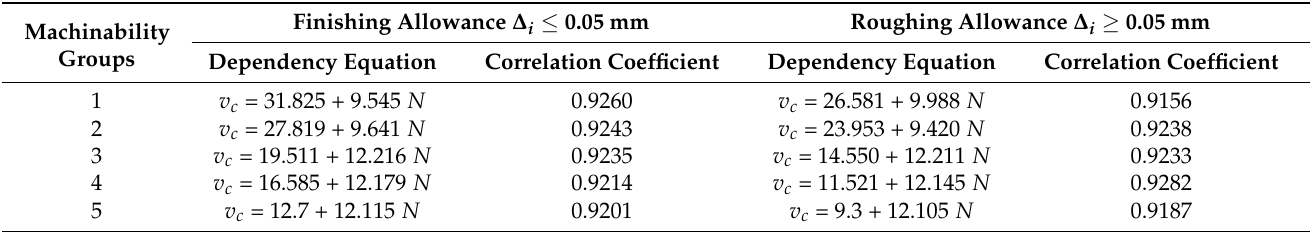
Table 6. Empirical linear functions of the dependence of the grinding speed on the grain size of the belt.